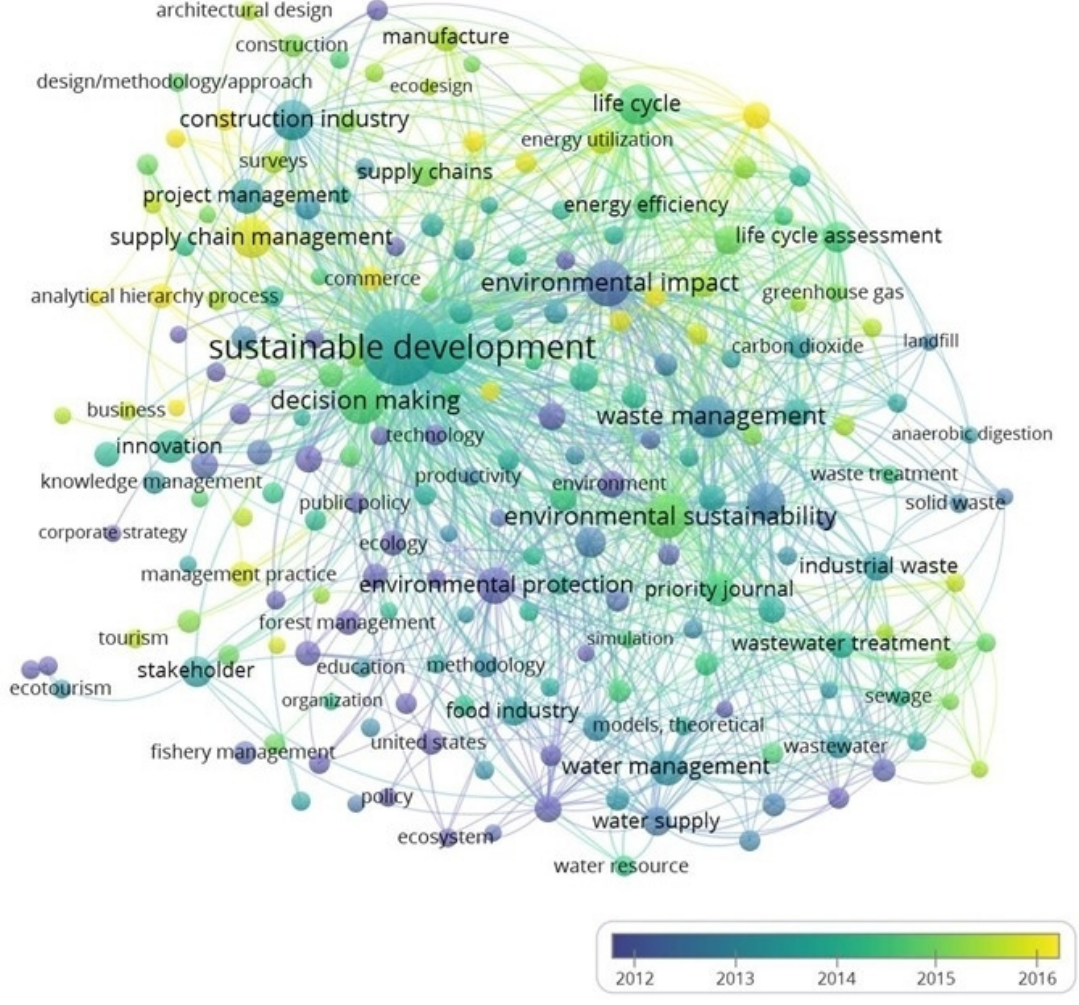
Figure 7. Evolution of keywords network map based on co-occurrence (1998–2019).